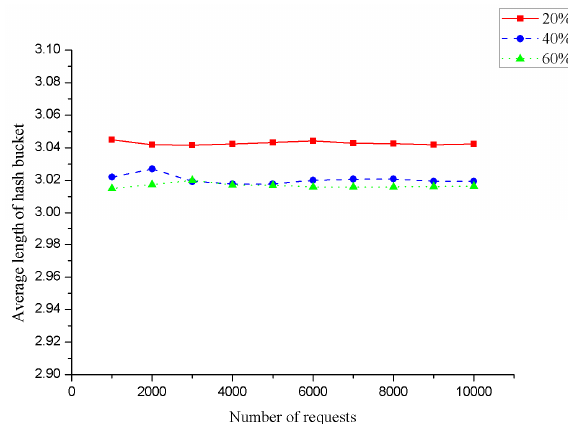
Figure 11. Average Length of Hash Buckets of Different Interval Rates.